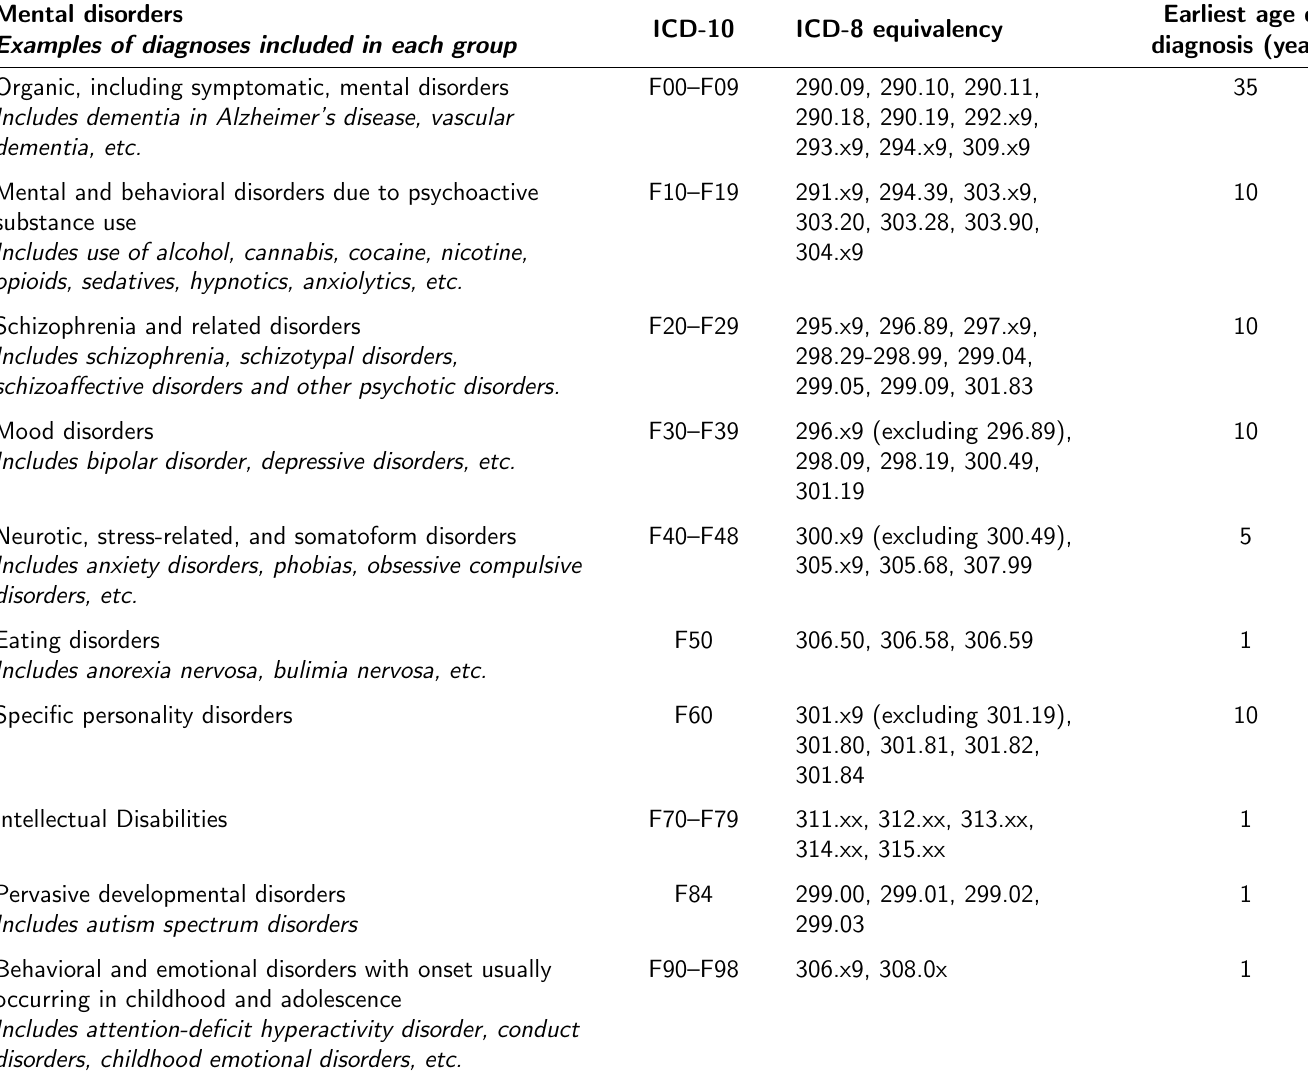
Supplementary Table 2: Mental disorders and their